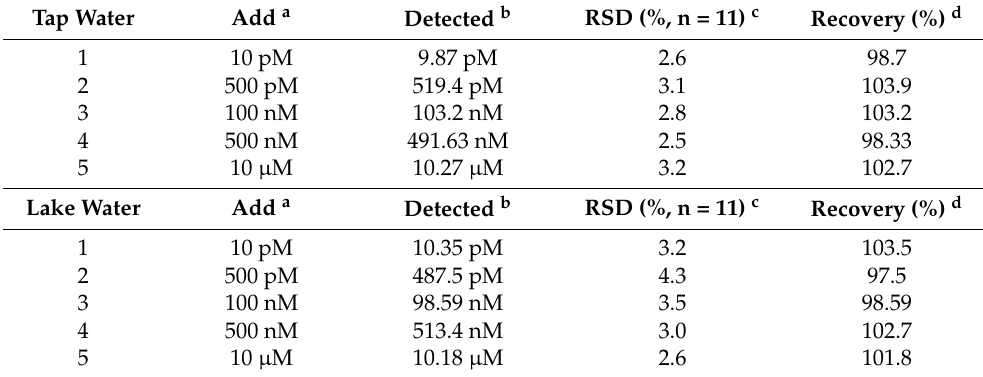
Table 1. Practical determination of 2,4-D in real samples.